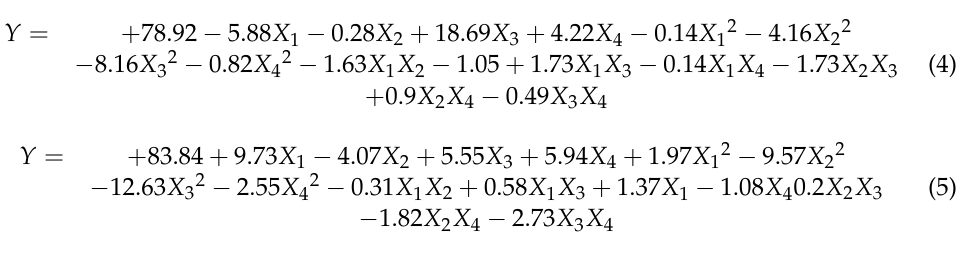
Table 3. Central composite design matrix for BSFL biodiesel